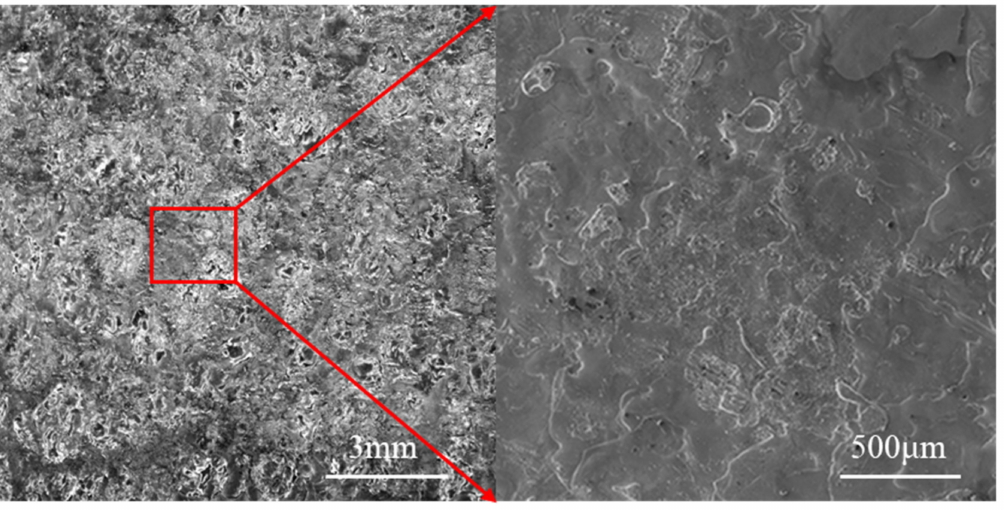
Figure 3. Typical Mo coating